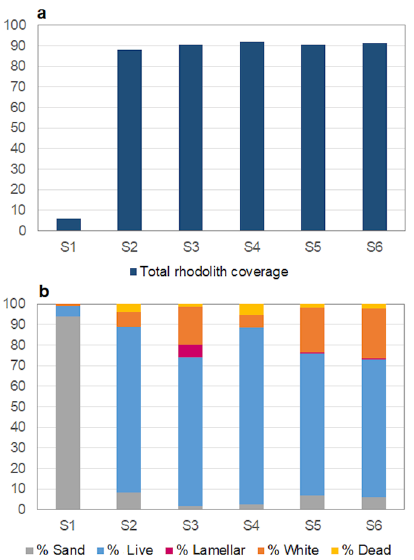
Figure 4. ( a ) Percentage of total rhodolith coverage in the six sampling sites; ( b ) percentage of the different components of videoframe coverage in the six sampling sites.